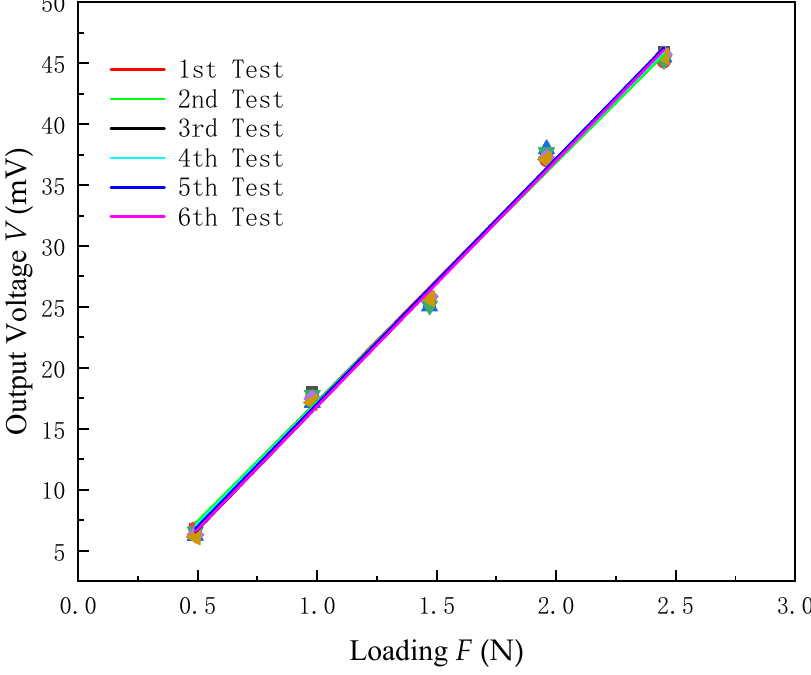
Figure 14. Output voltage of the same piezoelectric film sensor under identical conditions.